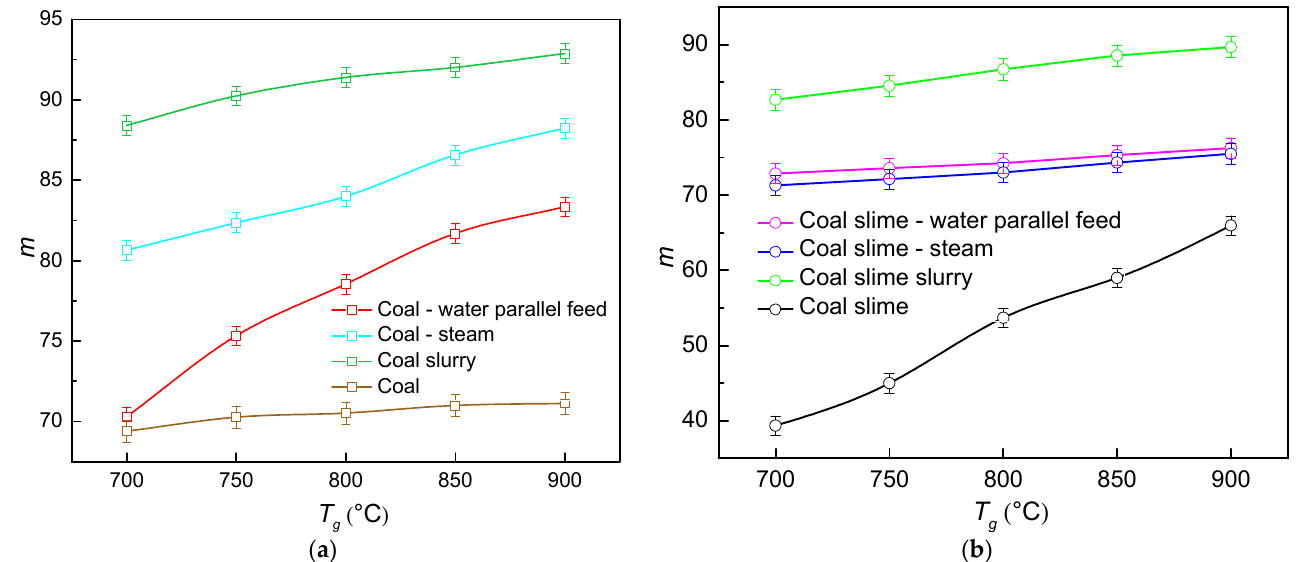
Figure 9. Relative indicator of completeness of reactions of fuels based on bituminous coal ( a ) and coal slime ( b ) when varying the scheme of introducing the components and temperature into the combustion chamber.